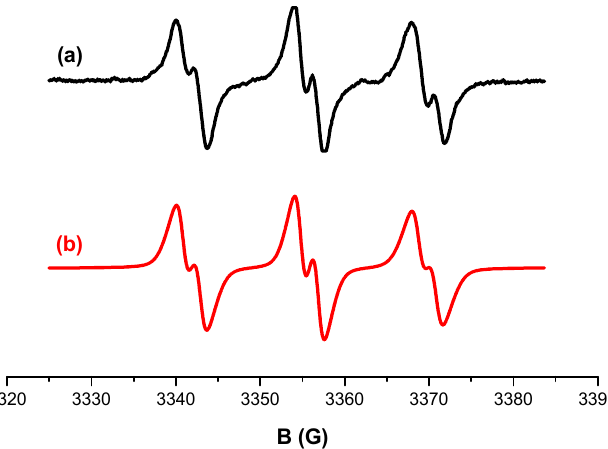
Figure 2. Electron spin resonance (ESR) spectra of the radicals generated in CQ/S5 (0.05M/0.01M) and trapped by phenyl- N - tert -butylnitrone (PBN) (0.01M) in tert -butylbenzene upon exposure to a LED@477 nm (SmartLite Focus): N 2 saturated medium Ph • /PBN hyperfine coupling constants: a N = 13.96 G, a H = 2.06 G; ( a ) experimental and ( b ) simulated spectra.